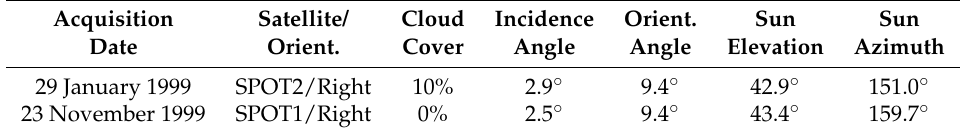
Table 2. SPOT data used in this study, resolution 10 m.